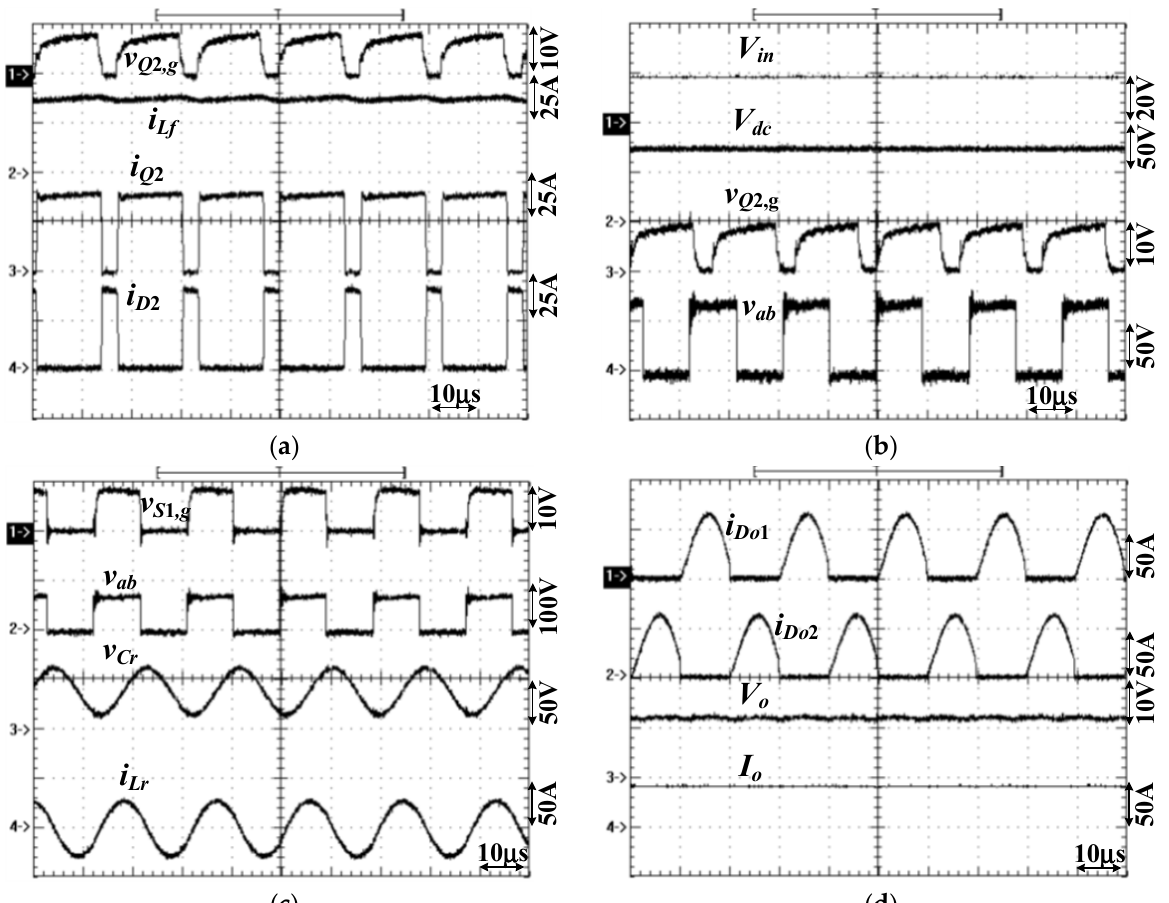
Figure 6. Measured results at V in = 18 V and P o = 500 W ( a ) v Q 2, g , i Lf , i Q 2 and i D 2 ( b ) V in , V dc , v Q 2,g and v ab ( c ) v S 1, g , v ab , v Cr and i Lr ( d ) i Do 1 , i Do 2 , V o and I o .